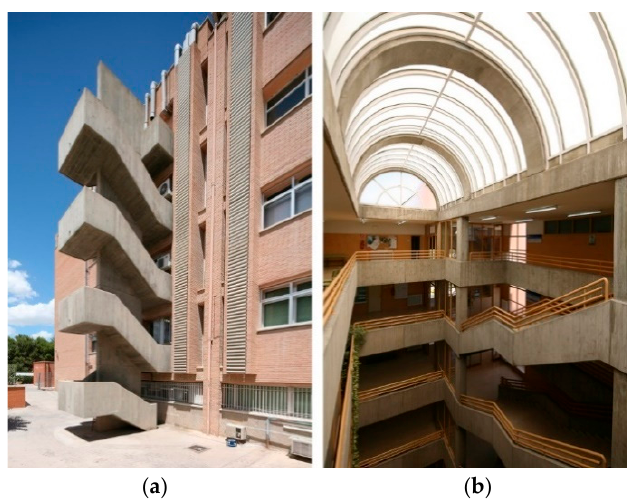
Figure 12. FS: Views of the concrete stairways ( a ) and interior glazed vaults ( b ). Photo: Courtesy of UA’s Technical Office.